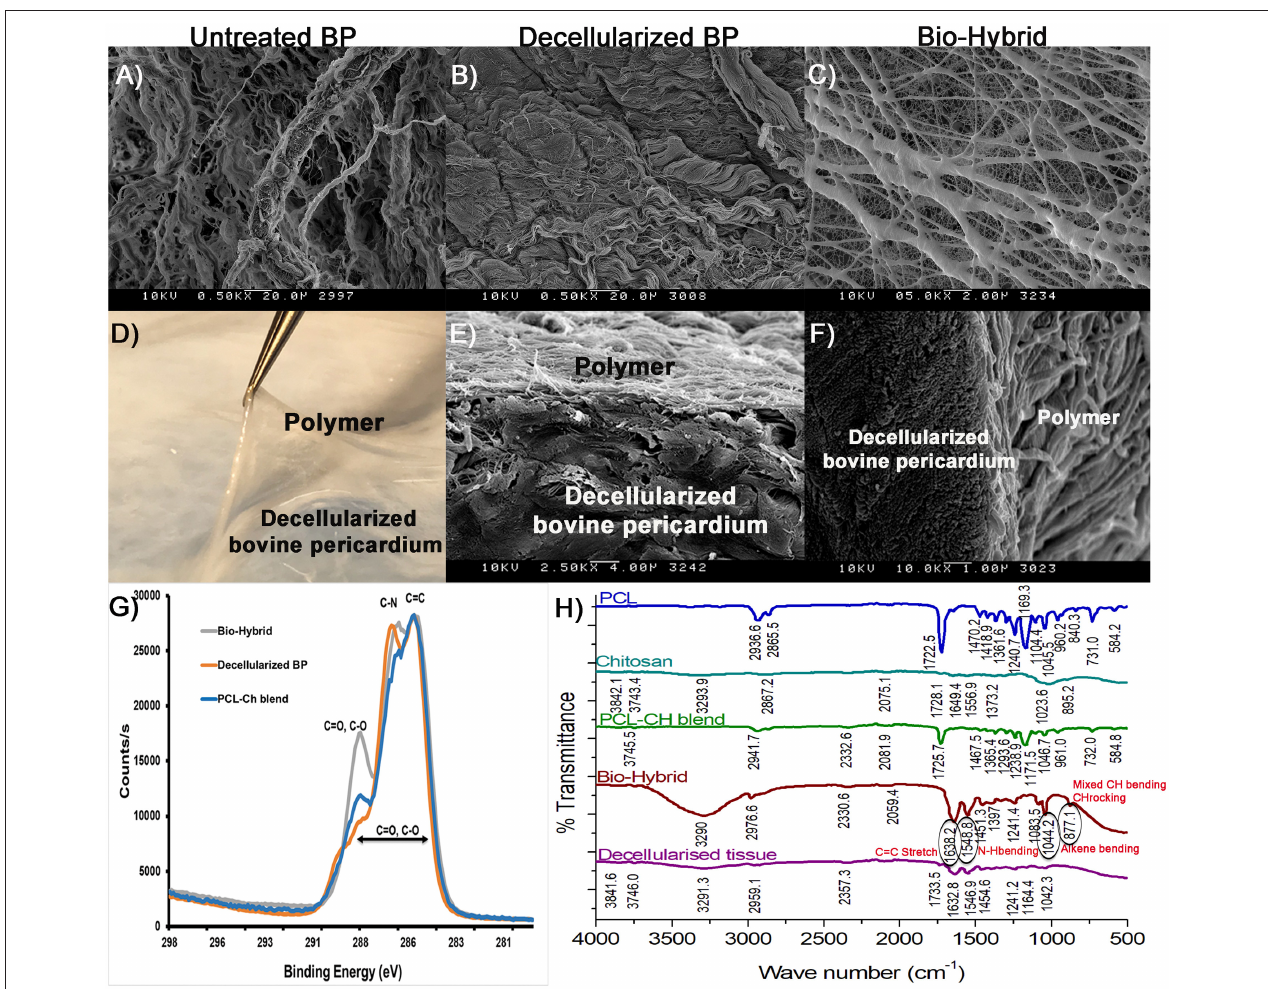
FIGURE 3 | Polymer-tissue interface characterization in the biohybrid composite. (A–C) SEM images of the untreated BP, decellularized BP, and the biohybrid showing the presence of cells in the untreated BP, absence of cells in decellularized BP, and coating of electrospun polymer nanofibers on the decellularized BP in the biohybrid composite, (D–F) photograph of the biohybrid composite showing lifting of polymer from the decellularized BP followed by SEM images of the cross-sectional views of the biohybrid showing presence of polymer fibers at the interface without separation at the interface, (G) carbon scanning of the biohybrid, decellularized BP, and polycaprolactone:chitosan blend by X-ray photoelectron spectroscopy showing difference in binding energy corresponding to peaks C = C, C = O, C-O, and C-N in the biohybrid, and (H) Fourier transform IR spectroscopy of polycaprolactone, chitosan, blend, the biohybrid, and decellularized BP